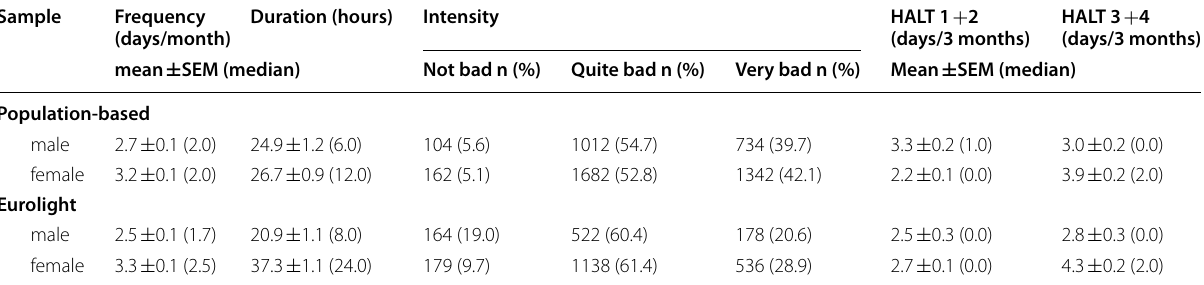
Table 2 Symptom burden (attack frequency, duration and intensity) and lost productivity (work days [HALT 1 [HALT 3 4]) in the two +